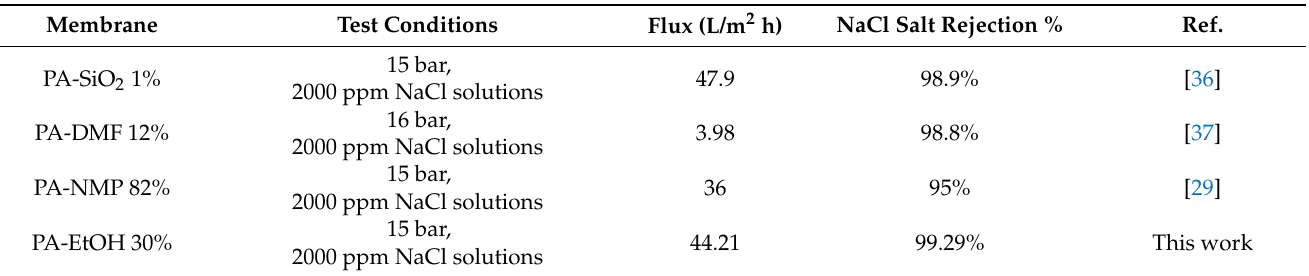
Figure 16. Salt rejection of PA and PA-EtOH (10%, 20%, and 30%). Table 2. Comparison of PA-EtOH 30% membrane with previously reported membranes for salt re- jection.